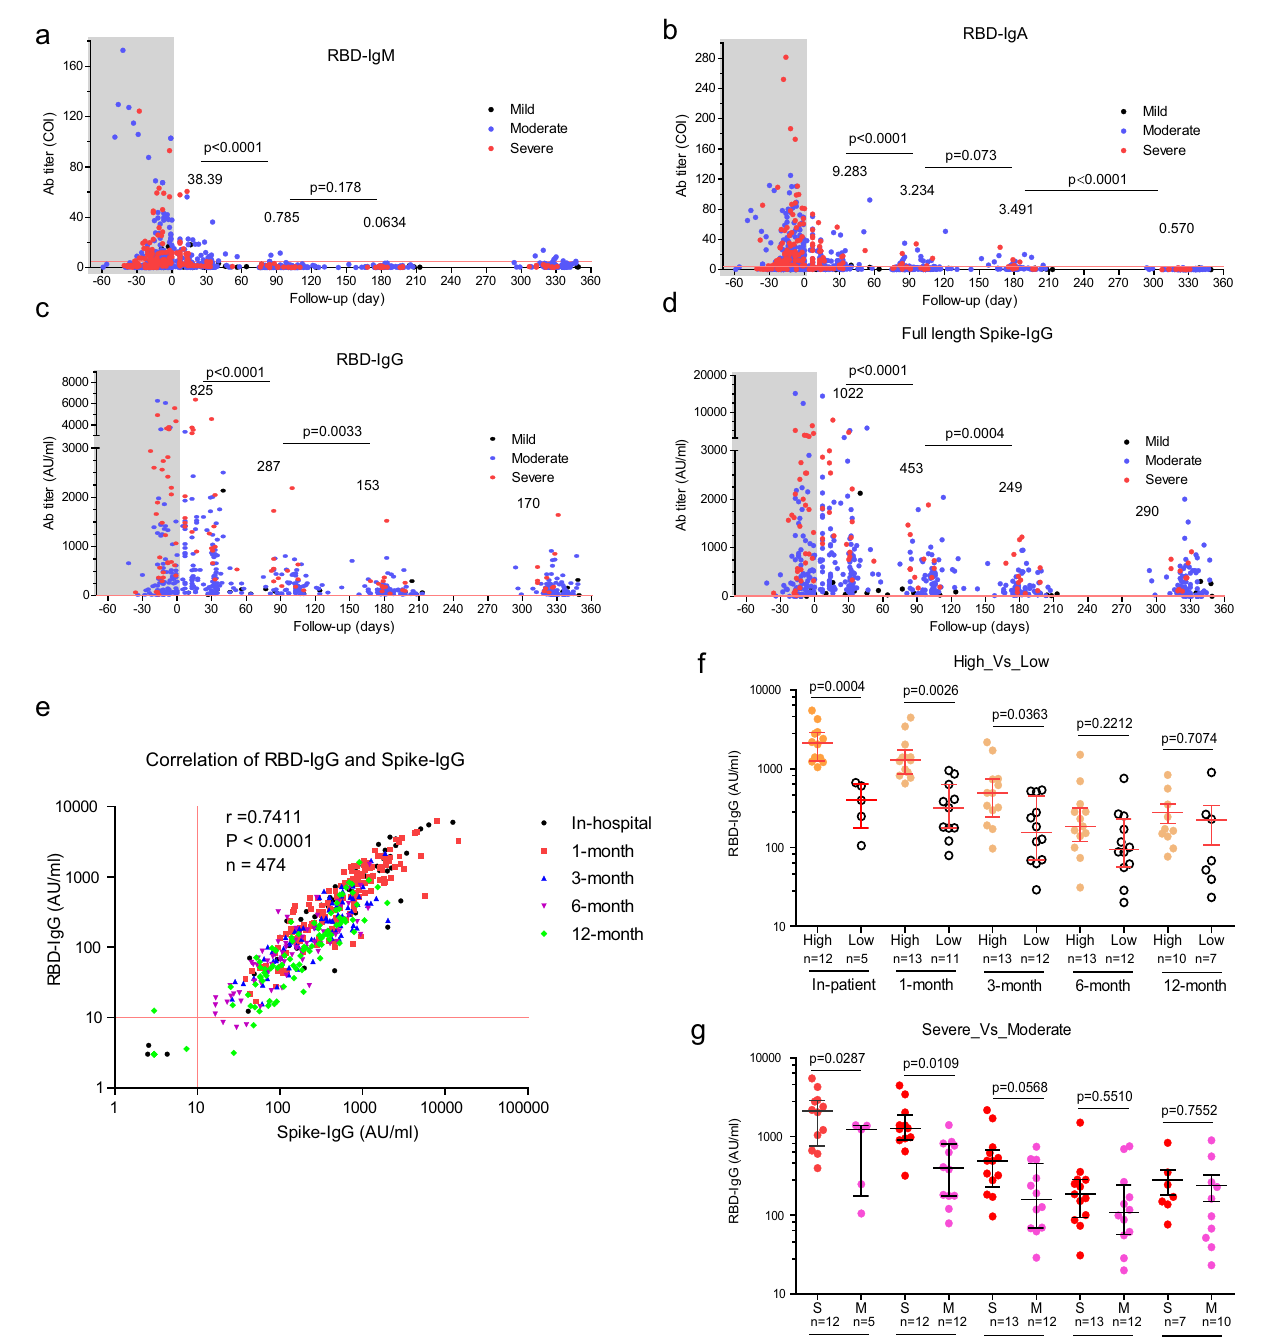
n=12 n=5 n=12 n=12 n=13 n=12 n=13 n=12 n=7 n=10